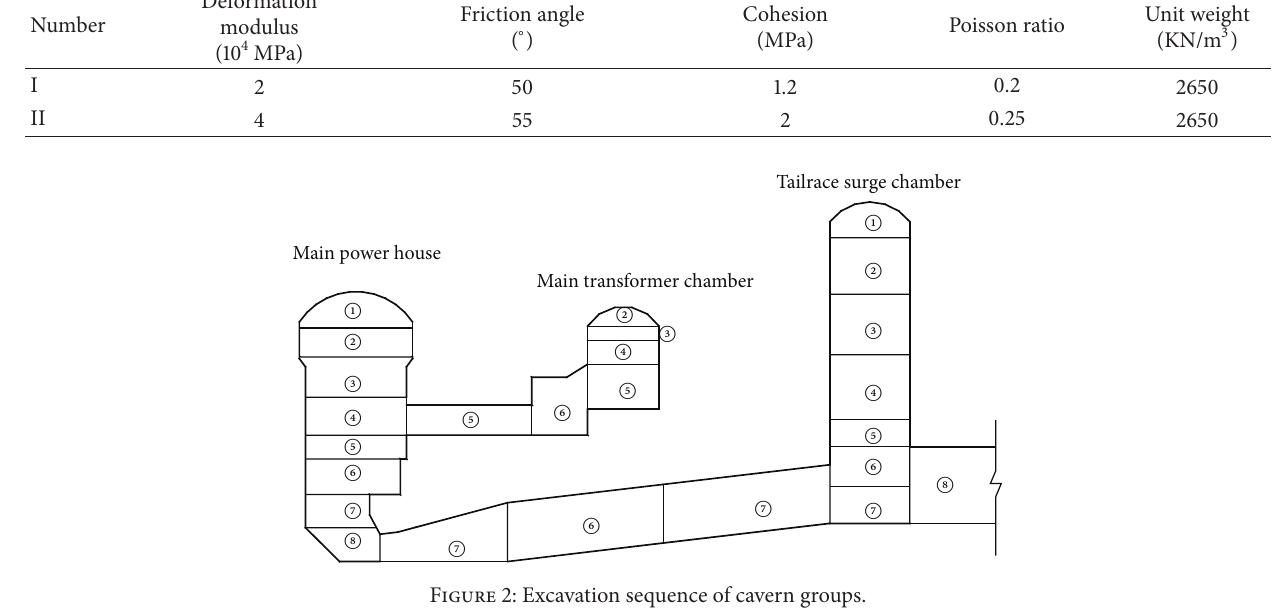
Figure 2: Excavation sequence of cavern groups.